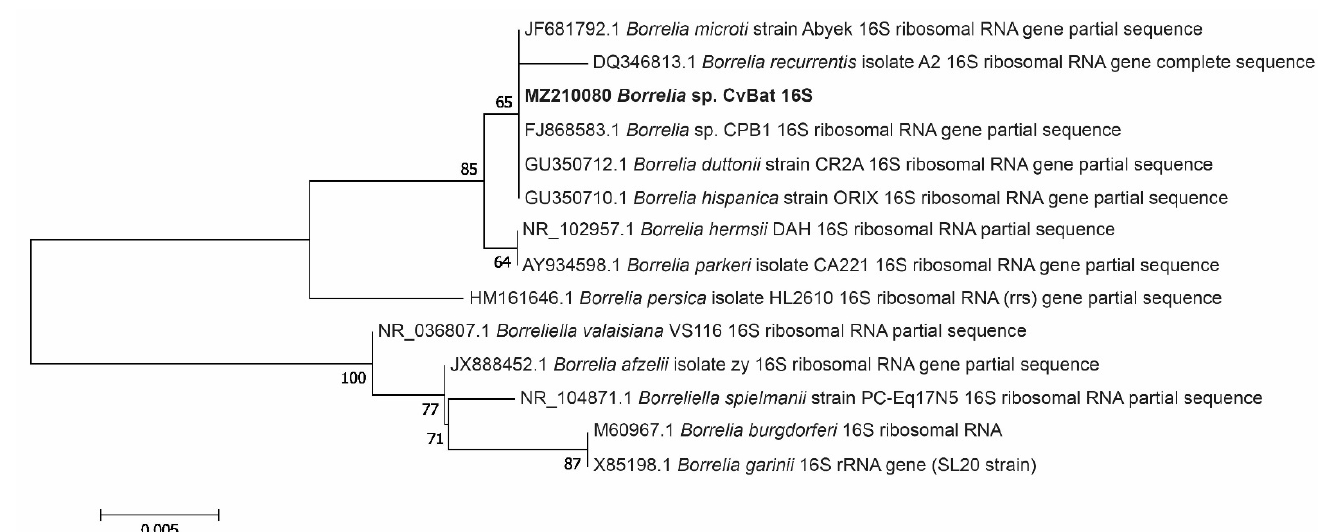
Figure 4. Phylogenetic tree based on 16S rRNA gene sequences of Borrelia species. Sequences detected in our study (‘‘MZ210080 Borrelia sp. CvBat 16S’’, n = 4) are highlighted in bold.